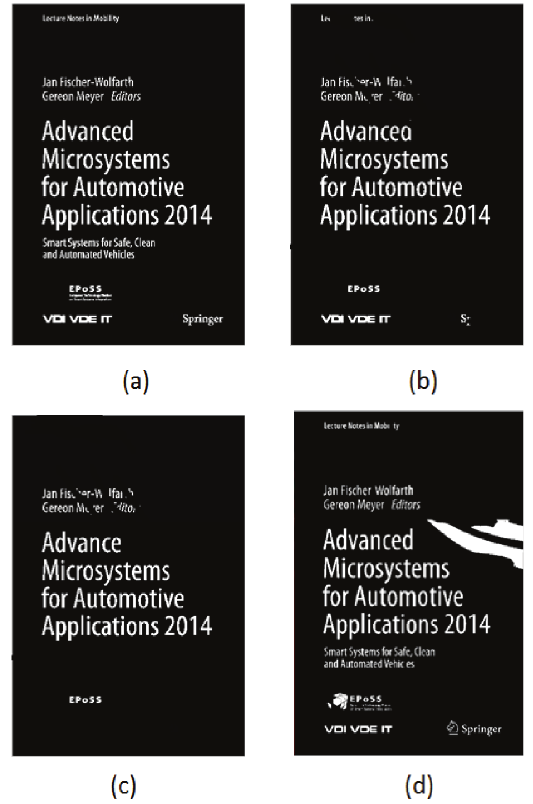
Figure 5: Result of textual regions extraction stage; (a) our result, (b) result of Jain and Yu’ method, (c) result of K.Sobottka, (d) result of Lluis and Dimos-